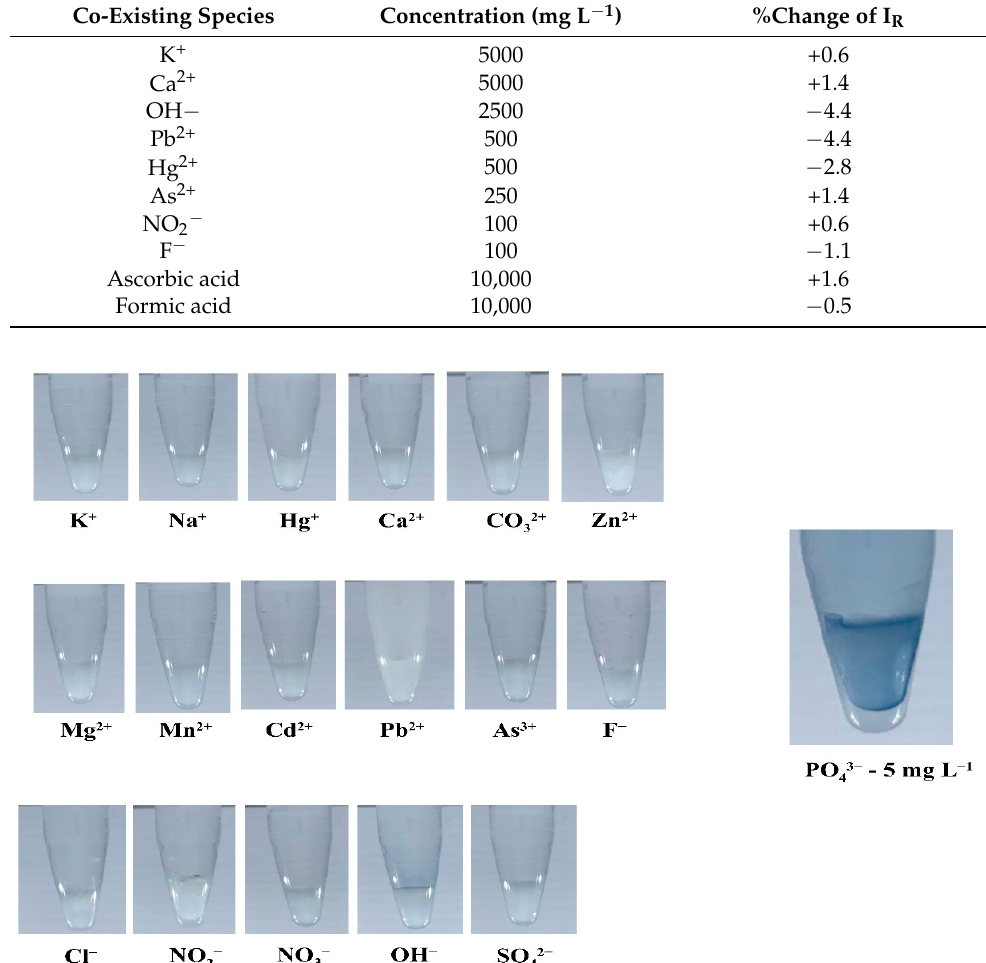
Table 4. Percentage recoveries from spiked real sample (P14), analyzed using in-tube hydrogel test kits and on-mobile DIC.